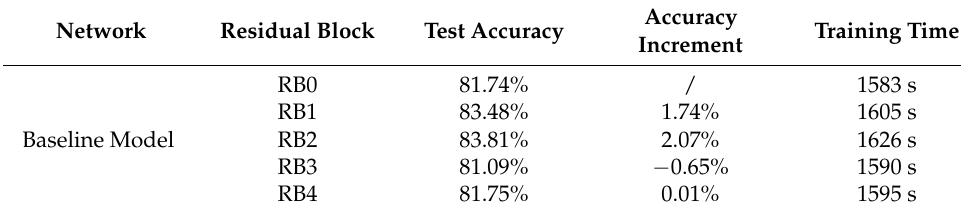
Table 5. Test results of the residual block